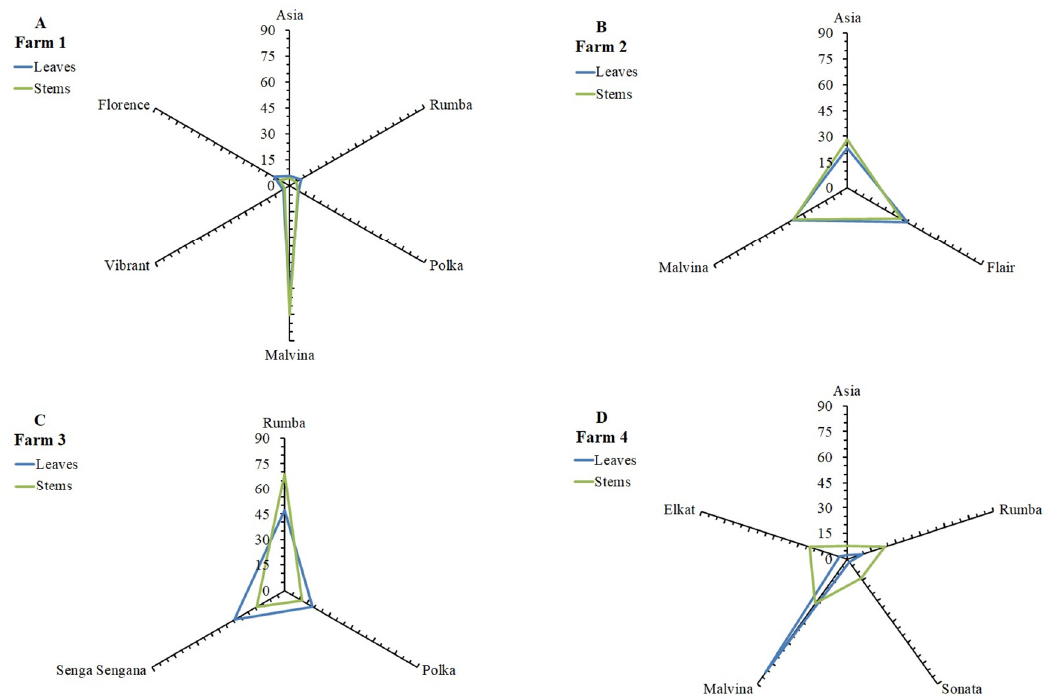
Figure 2. Fungal contamination of various strawberry cultivars leaves and stems (%). ( A ) Farm 1 cv. ‘Asia’, ‘Rumba’, ‘Polka’, ‘Malvina’, ‘Vibrant’, ‘Florence’; ( B ) Farm 2 cv. ‘Asia’, ‘Malvina’, ’Flair’; ( C ) Farm 3 cv. ‘Rumba’, ‘Polka’, ‘Senga Sengana’; ( D ) Farm 4 cv. ‘Asia’, ‘Rumba’, ‘Sonata’, ‘Malvina’, ‘Elkat’. Results are presented as means ( n = 4).